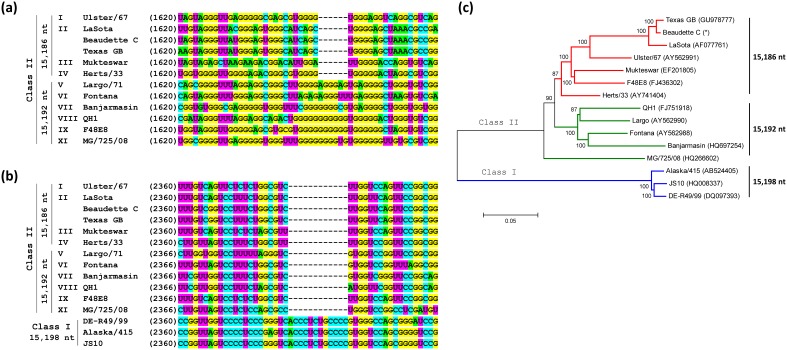
Nucleotide sequence alignment and phylogenetic tree analysis of NDV strains.(a) Nucleotide (nt) sequence alignment of part of the 5′ (downstream) non-translated region (NTR) of the Nucleocapsid protein (N) gene of NDV strains to illustrate the 6-nt insert that is characteristic of 15,192-nt size class viruses. (b) Nt sequence alignment of part of the ORF of the Phosphoprotein (P) gene NDV strains to illustrate the 12-nt insert that is found in many of the 15,198-nt size class viruses. All sequences shown are negative-sense and gaps indicate absence of the insert sequence. The nucleotide residues are color coded; U-violet, A-green, G-yellow and C-blue. (c) Phylogenetic tree analysis based on the nt sequences of complete genomes of NDV strains. Note the clustering of NDV strains with respect to their genome-length. Branches in each cluster is color coded: red-15,186 nt; green-15,192 nt; blue-15,198 nt. The tree was constructed by bootstrap analysis (1000 replications) using the neighbor-joining of the Kimura-2-parameter method for nt differences in the MEGA 4.0 phylogenetic analysis program [21]. Scale bar shows number of base substitutions per site. Bootstrap values are shown at the nodes. Note the clustering of unique genome-length viruses. Asterisk (*) indicate the reference for the sequence of strain BC [11]. The genetic class designations are indicated for NDV strains in all three panels.